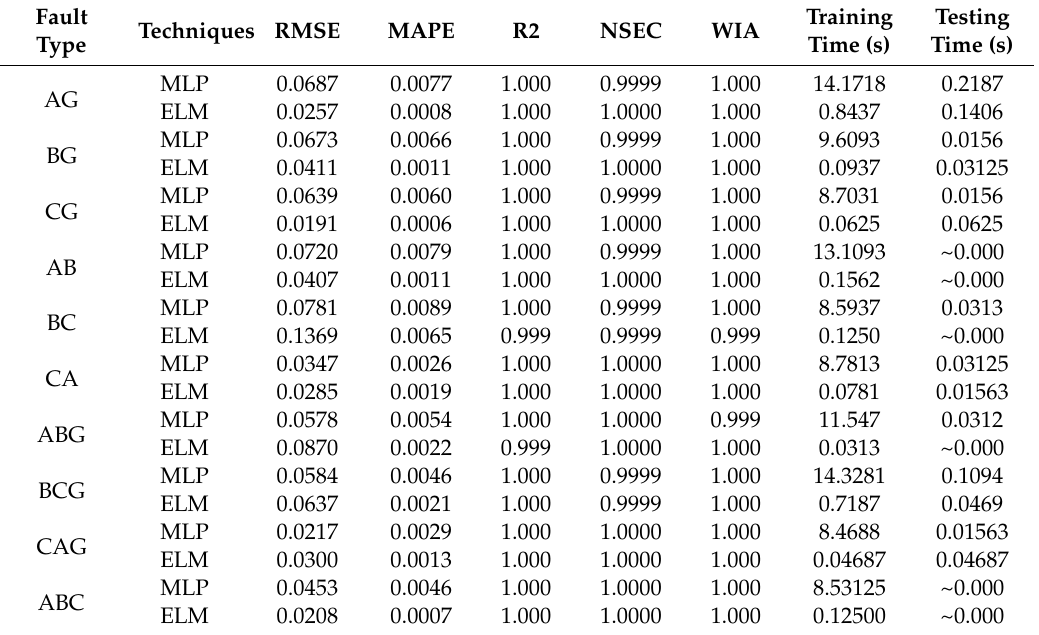
Table 3. Performance measurements of MLP and ELM for locating faults in a distribution system with balanced load.